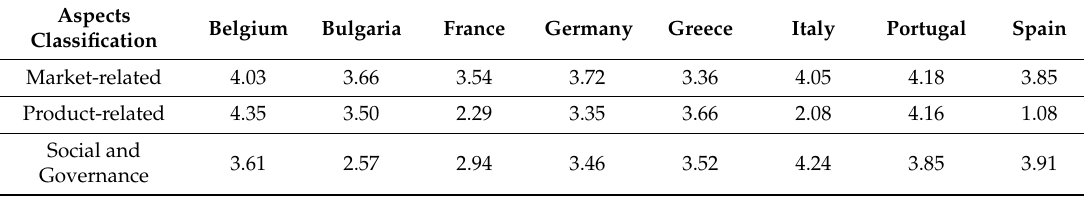
Table 3. Categories average evaluation.